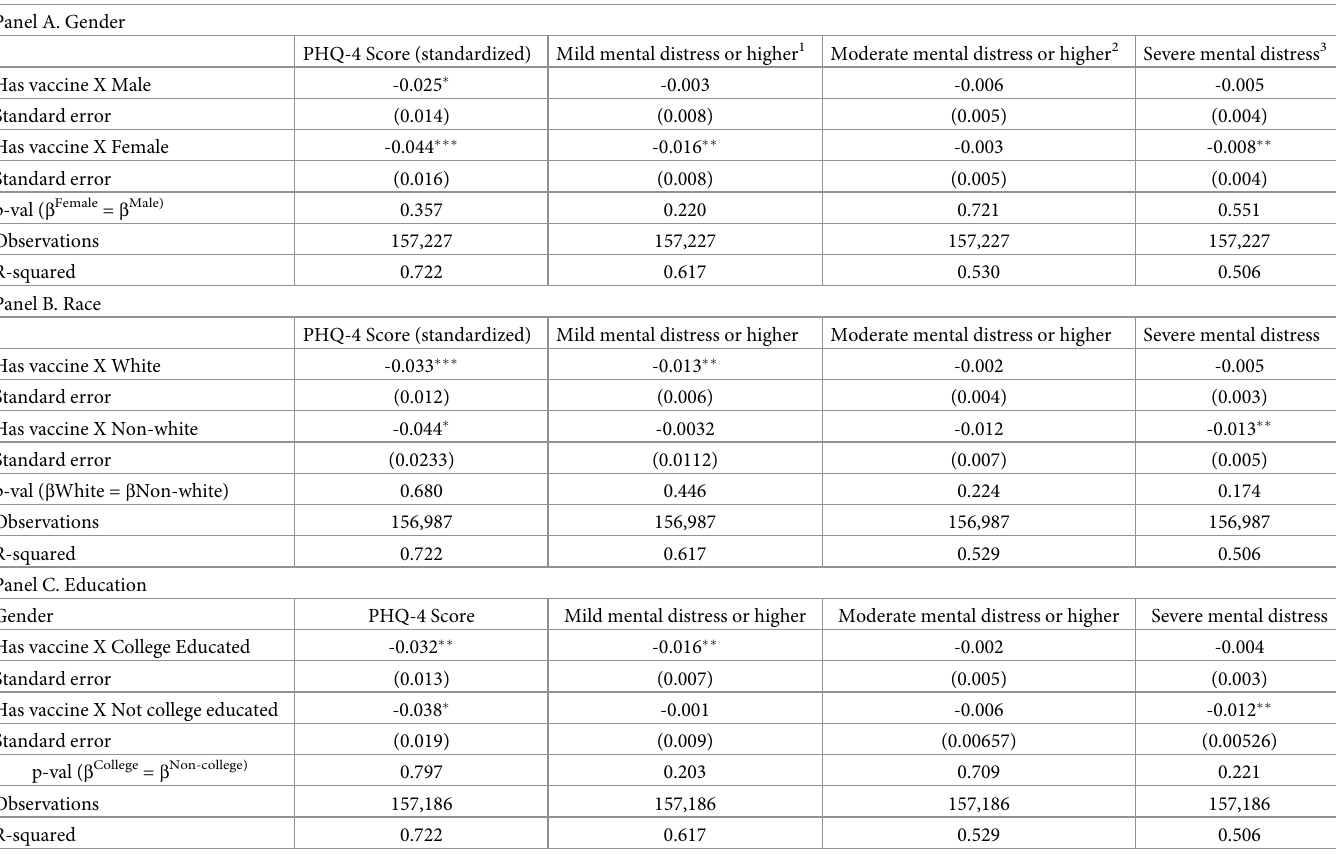
Table 3 shows the results of the heterogeneity analyses. The effect on standardized PHQ4-scores is found to be higher for women, β Female = -0.4, p-value < 0.01, than for men, β Male = -0.02, p-value = 0.08, although we cannot rule out that the effects are equal for men and women (p-value for the test of β Female = β Male equals 0.36). The effects for mild mental distress or higher , and severe mental distress are statistically sig- nificant for women but not for men. The coefficients imply that getting vaccinated reduced the probability of being at least mildly depressed for women by 1.6 percentage points (5% reduc- tion compared to the base value, p-value < 0.01 and the probability of being severely depressed or higher by 0.8 percentage points (15% reduction, p-value < 0.01) The coefficients for PHQ-4 scores for both White and non-White respondents were nega- tive and insignificantly different across the two groups ( β White = -0.03, β Non-white = -0.04 , Table 3. Heterogeneity analysis. Panel A.